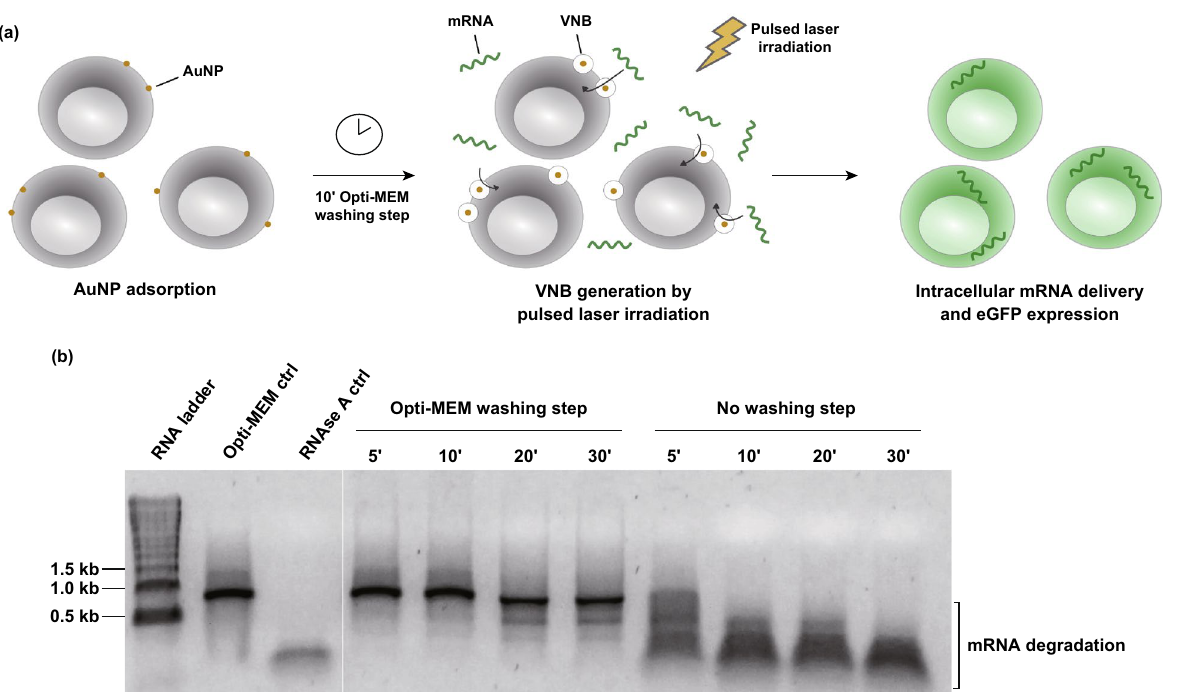
Fig. 1 Optimized procedure for mRNA transfection by vapor nanobubble (VNB) photoporation. a Schematic illustration of the VNB photopo- ration procedure for mRNA transfection. b Analysis of physical mRNA integrity by native agarose gel electrophoresis; 1 µg eGFP-mRNA was incubated on HeLa cells for the specified amount of time, either with or without a prior washing step with Opti-MEM. As controls, mRNA incu- bated only in Opti-MEM (Opti-MEM ctrl) or incubated for 30 min with 10 µg mL −1 RNAse A (RNAse A ctrl) was